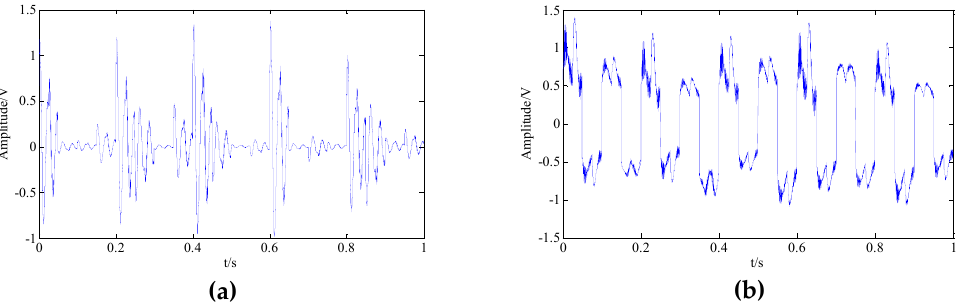
Figure 9. The result provided by canonical decomposition and parallel factors by alternating least squares method (CP-ALS): ( a ) shock signal in time-domain; and ( b ) harmonic signal in time-domain. Appl. Sci. 2017 , 7 , 418